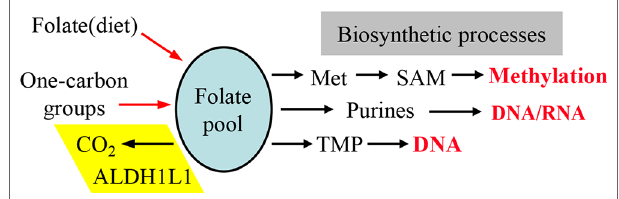
FiGURe 2 | One-carbon groups (derived from amino acid oxidation or formate) enter the folate pool and are directed towards three biosynthetic pathways (methionine, purines and thymidylate synthesis). Note that the enzyme ALDH1L1 diverts these groups from biosynthetic pathways thus serving a catabolic function. Input of folate from diet is required to support the intracellular levels of the coenzyme. SAM,